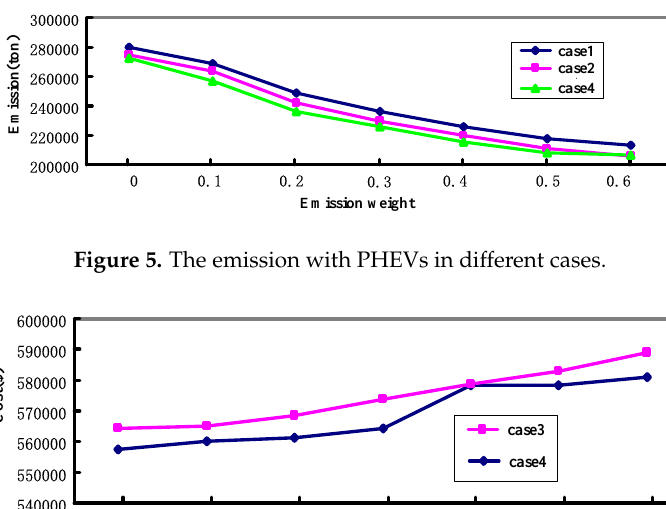
Figure 4. The operation cost with PHEVs in different cases.